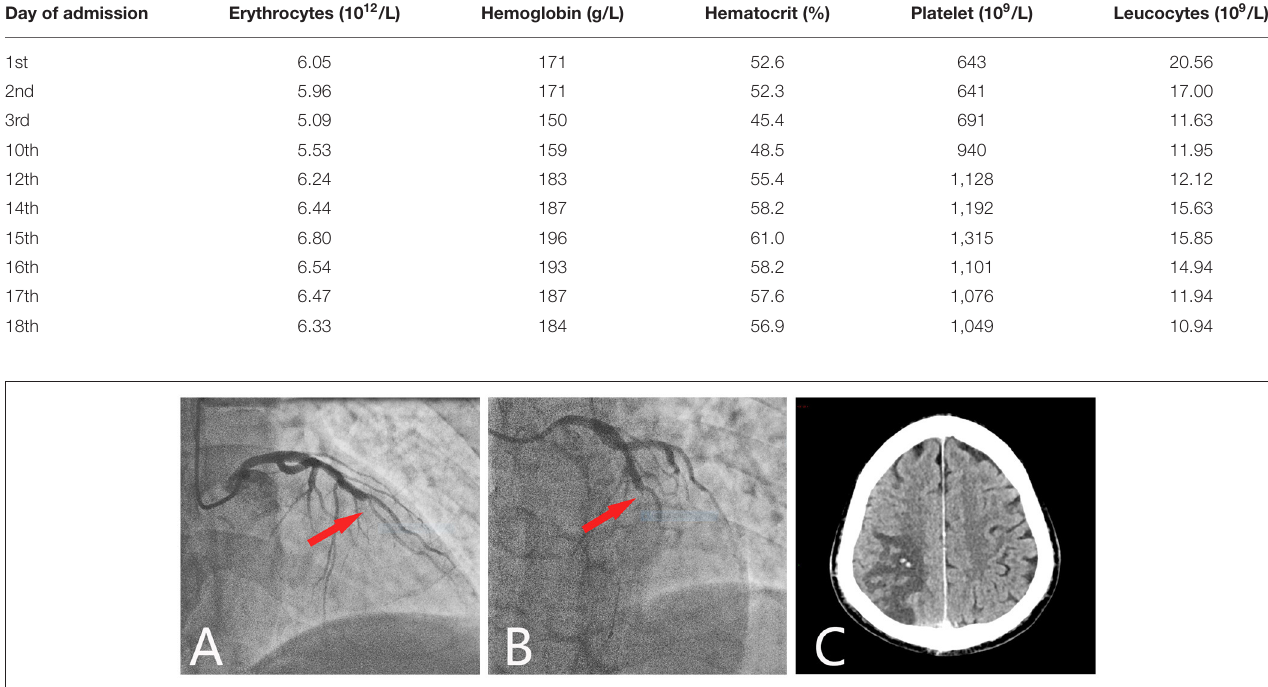
TABLE 1 | Blood routine results of the patient during hospitalization.